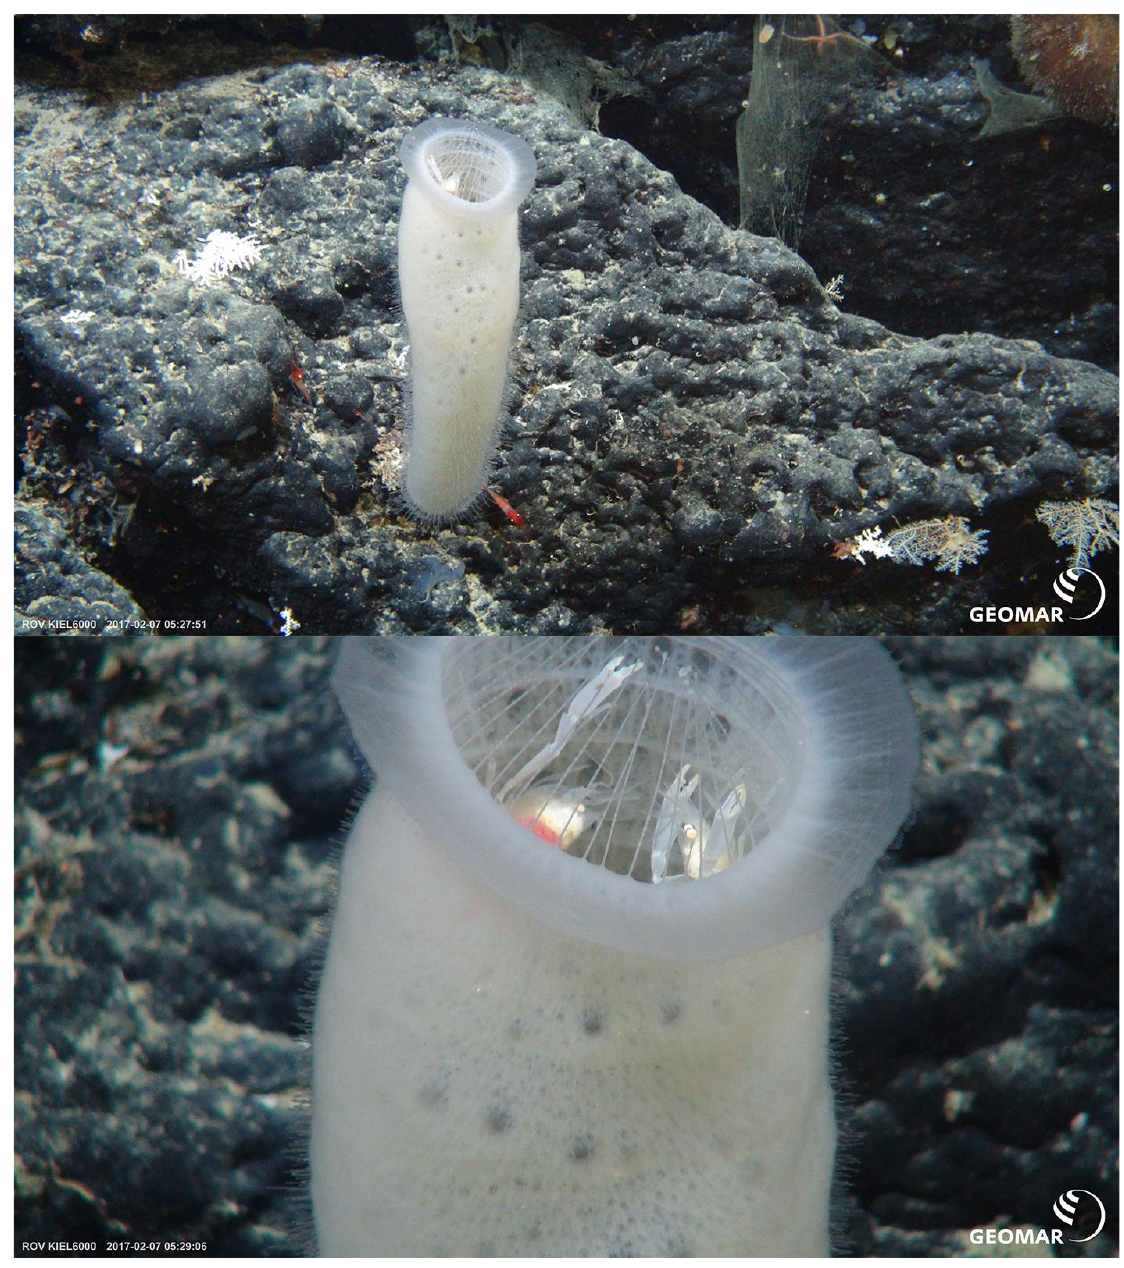
Figure 15. Spongicoloides sonne sp. nov. (pair NIWA 127110 and NIWA 127111) sponge host Corbitella sp. (det. Henry Reiswig, University of Victoria, Victoria, BC, Canada), Lyssacinosida, immediately prior to collection on the southern Kermadec Ridge (1168 m). Image courtesy of ROV Kiel 6000 GEOMAR, SO254 voyage PoriBacNewZ,